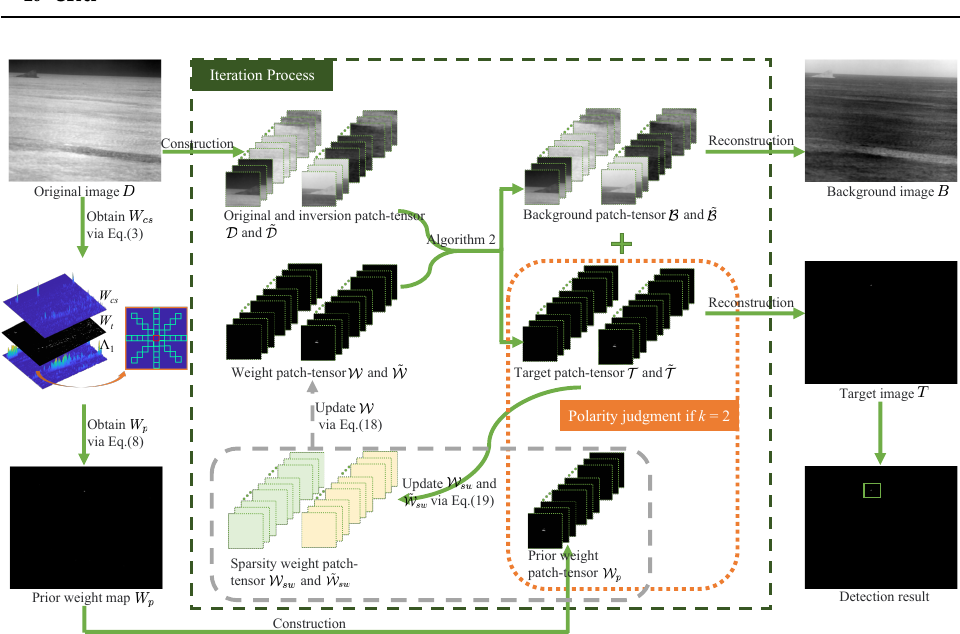
Figure 6. The overall procedure of the proposed method. k = 2 denotes the second